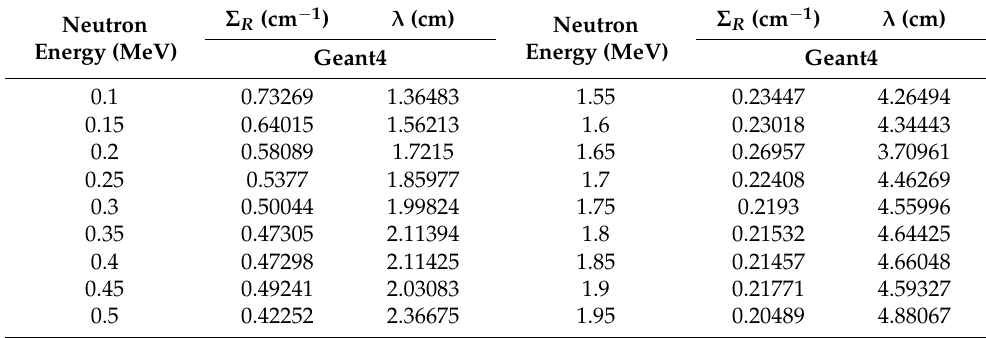
Table 6. The neutron removal cross-sections and mean free paths of PSU in the investigated energy range as found using